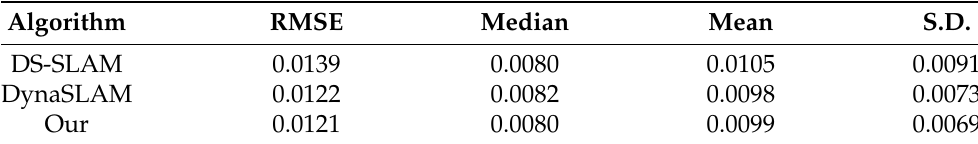
Table 7. RPE comparison (RPE includes RMSE [m], Median [m], Mean [m], S.D. [m]).